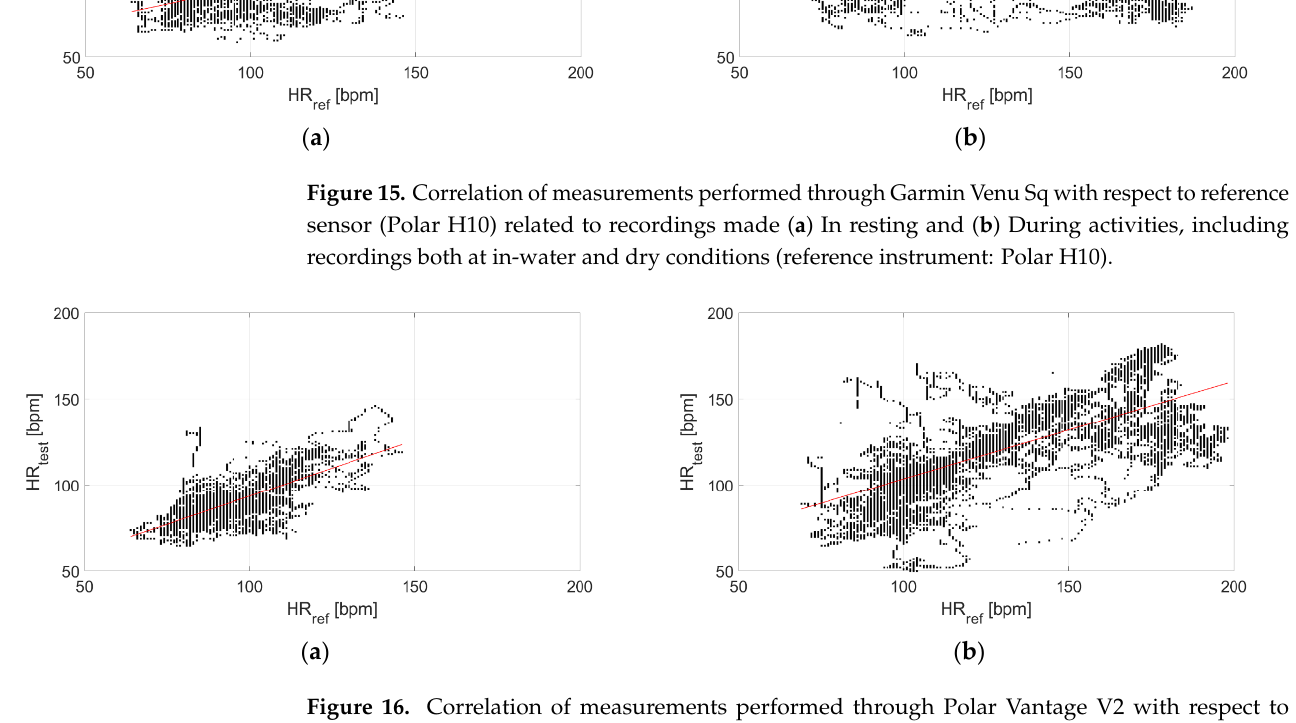
Figure 16. Correlation of measurements performed through Polar Vantage V2 with respect to reference sensor (Polar H10) related to recordings made ( a ) Resting and ( b ) During activities, including recordings both at in-water and dry conditions (reference instrument: Polar H10).